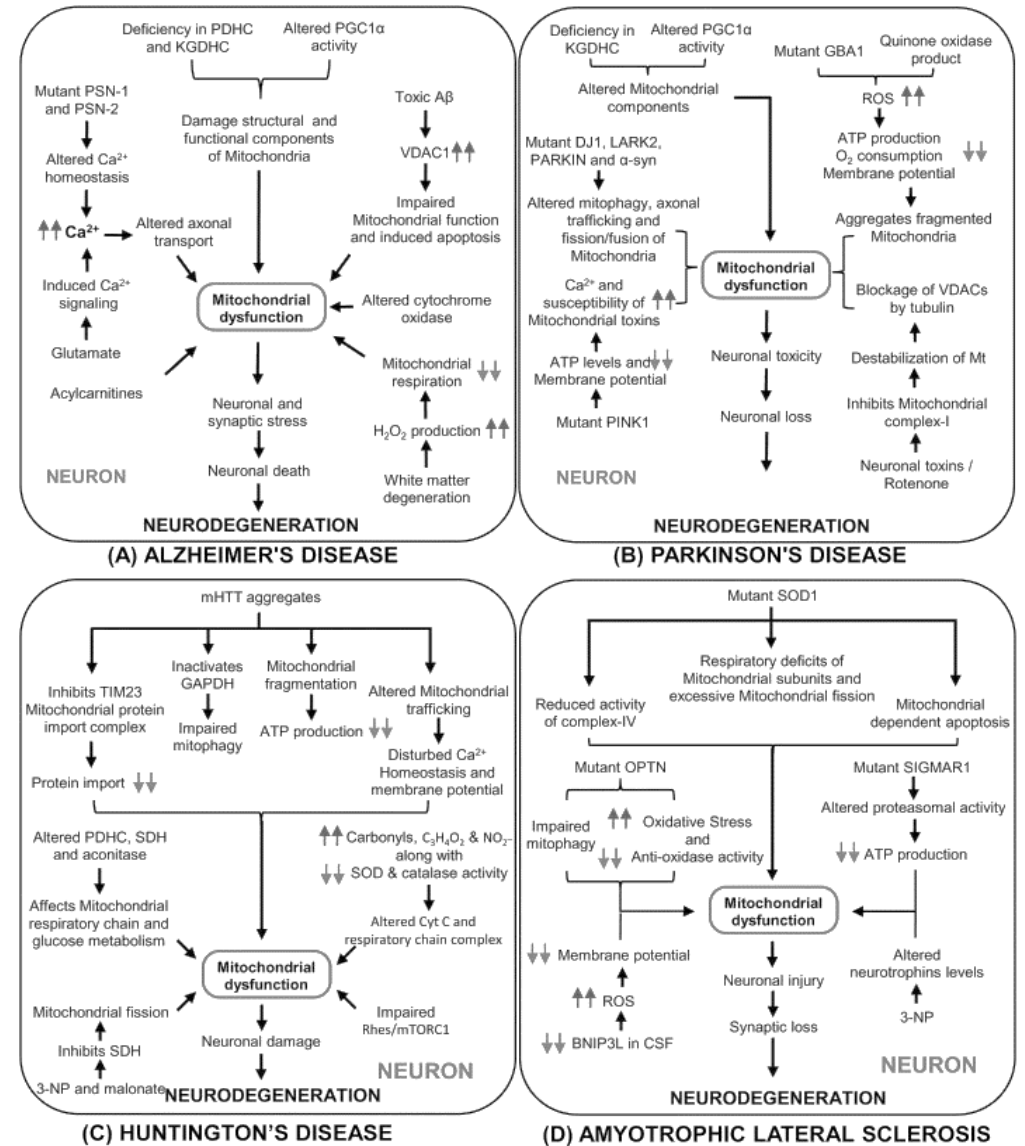
Figure 1. The molecular process by which mitochondrial failure mediates the pathogenesis of neu- rodegenerative diseases. PGC1, peroxisome proliferator-activated receptor gamma coactivator 1- alpha; PSN-1 and PSN-2, presenilin-1 and presenilin-2; VDAC1, voltage-dependent anion channel 1; GBA1, glucocerebrosidase 1; GAPDH, glyceraldehyde-3-phosphate dehydrogenase; PINK1,